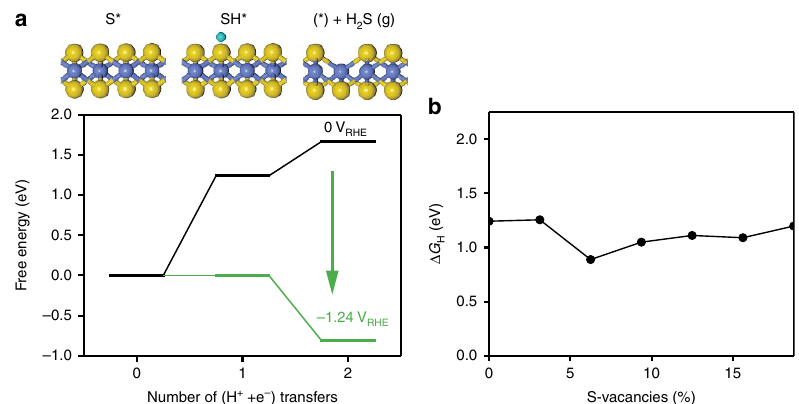
Figure 2 | The EC desulfurization process. ( a ) Free energy diagram for the protonation and removal of S. The green line indicates the free energy pathway at the applied potential required to make all paths exergonic. An illustration of the EC desulfurization process corresponding to the steps is shown above the plot. ( b ) Hydrogen adsorption free energy ( D G H ) onto a sulfur atom on the basal plane for each concentration of S-vacancies. NATURE COMMUNICATIONS|8:15113|DOI: